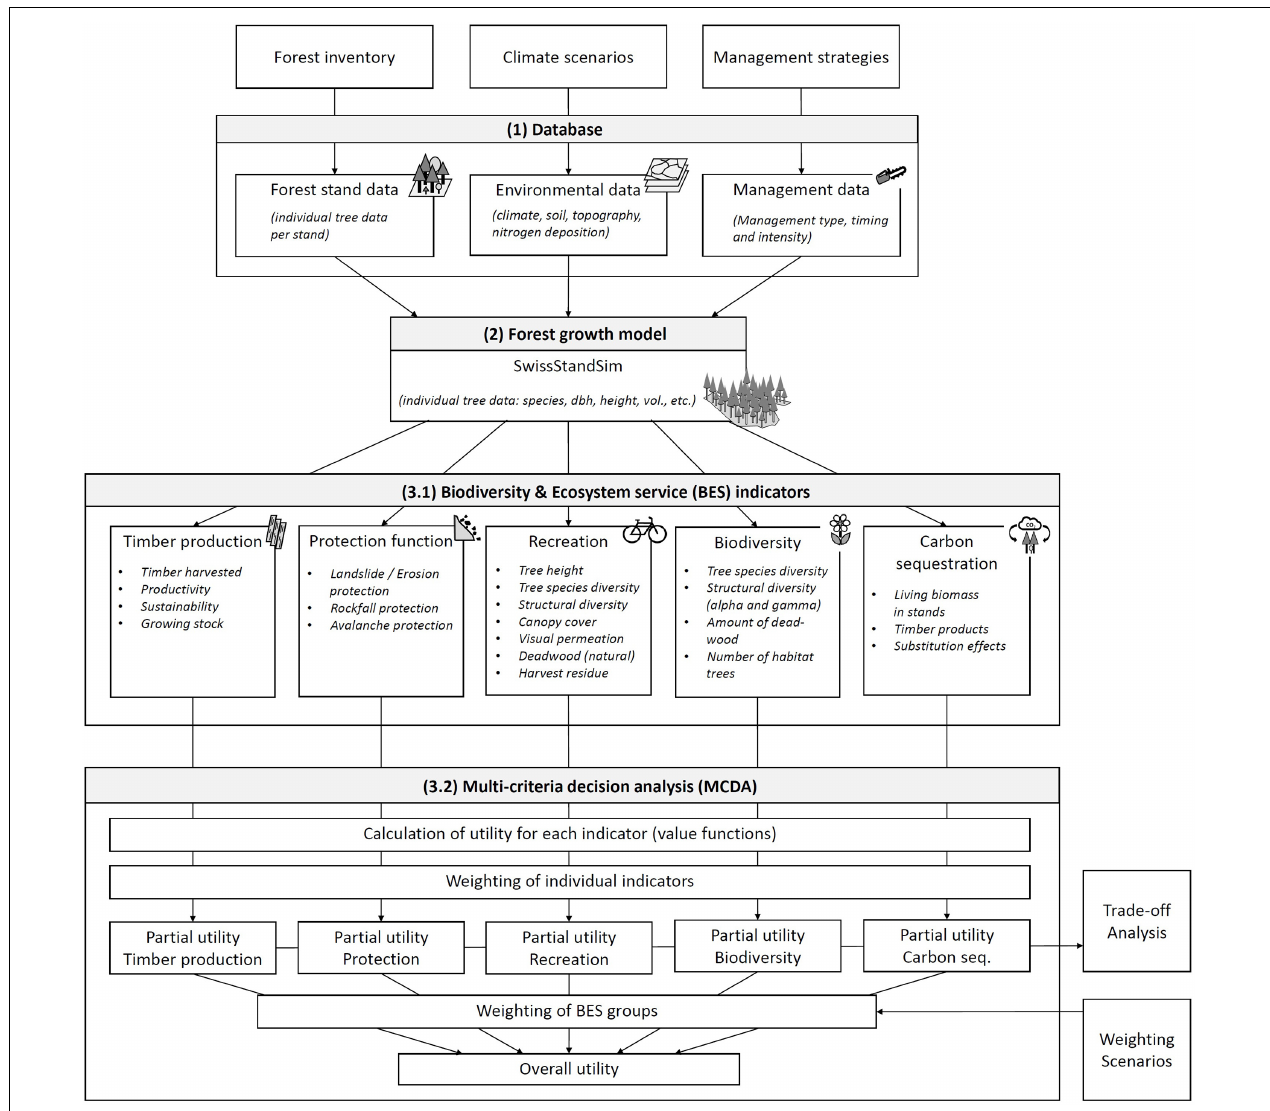
FIGURE 2 | Structure of the decision support system (DSS), consisting of three main components, a database (1), a forest growth model (2) and a problem-processing system, comprising of a set of biodiversity and ecosystem service (BES) indicators calculated from the simulated forest characteristics (3.1) and a multi-criteria decision analysis (MCDA,